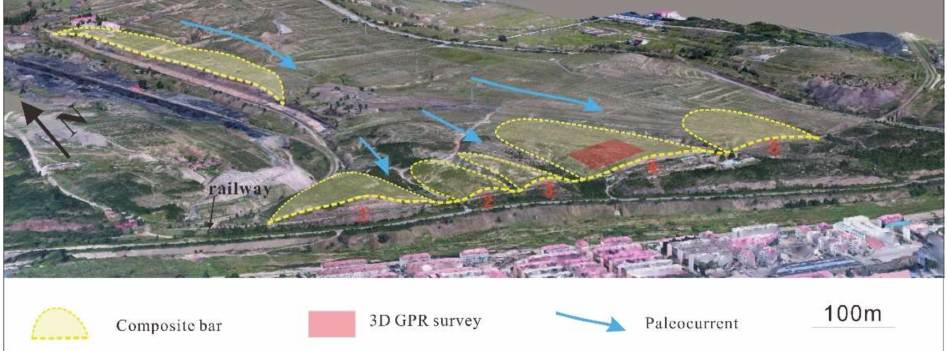
Figure 2. UAV aerial photos. Five compound bars cut by the railway can be identified, and there is a large pro-provenance channel bar section in the north. 3D GPR survey on the No.4 composite bar, 34 × 45 m in size.